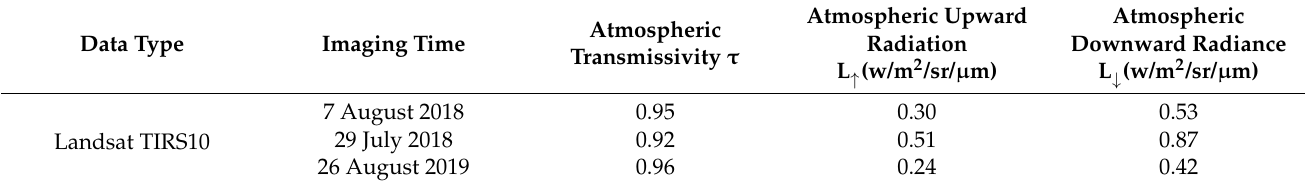
Table 2. Atmospheric profile